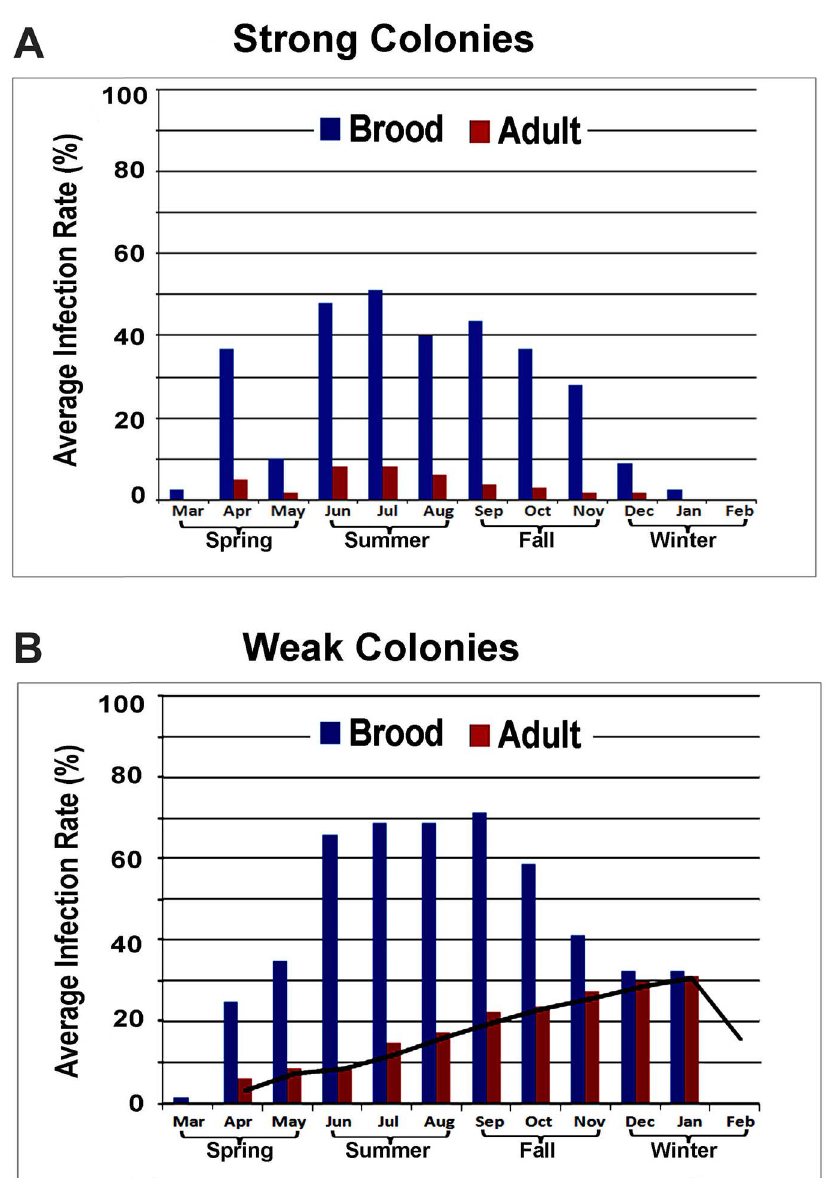
Figure 3. Average prevalence of IAPV infection in a single month. ( A ) Strong colonies. ( B ) Weak colonies. For both strong and weak colonies, the prevalence of IAPV infection in the brood was significantly higher than in adult bees. While strong colonies did not exhibit significant seasonal variation in IAPV infection, the infection rate of IAPV in adult bees in weak colonies increased from Spring to Summer and Fall and peaked in the Winter. All strong colonies survived through the cold winter months while the weak colonies collapsed before